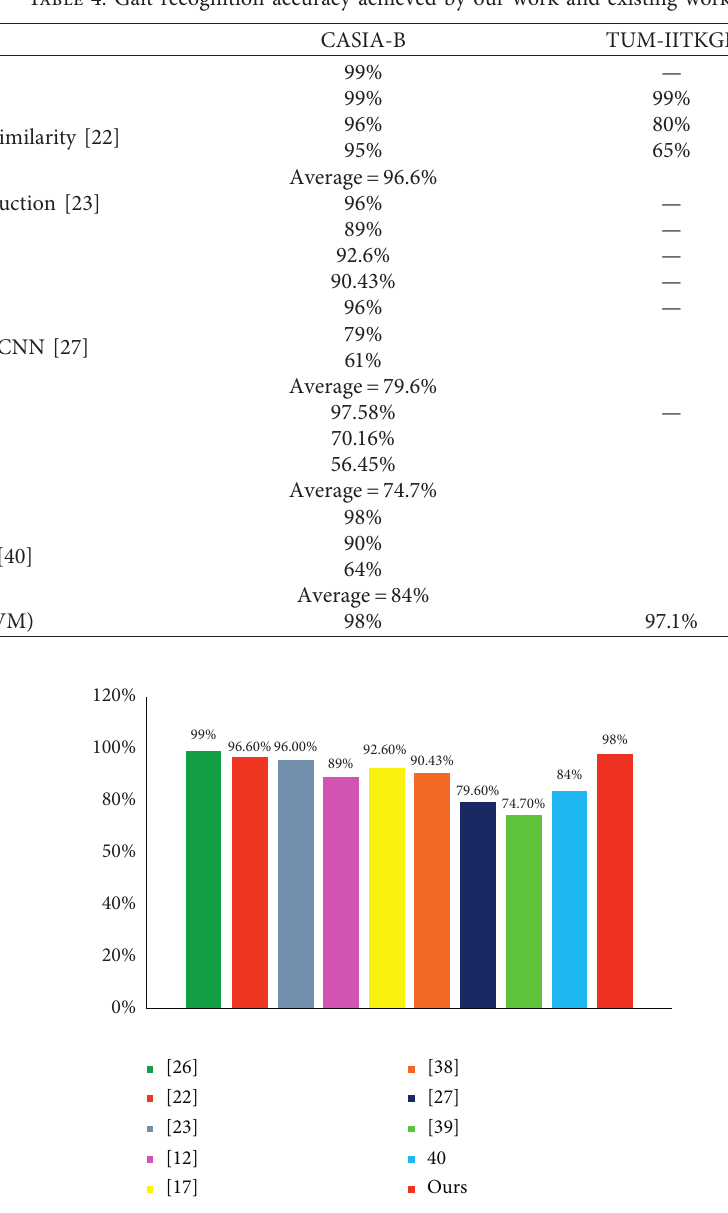
Figure 18: Relative standard deviation computed for pair 1, pair 2, and pair Table 4: Gait recognition accuracy achieved by our work and existing work.